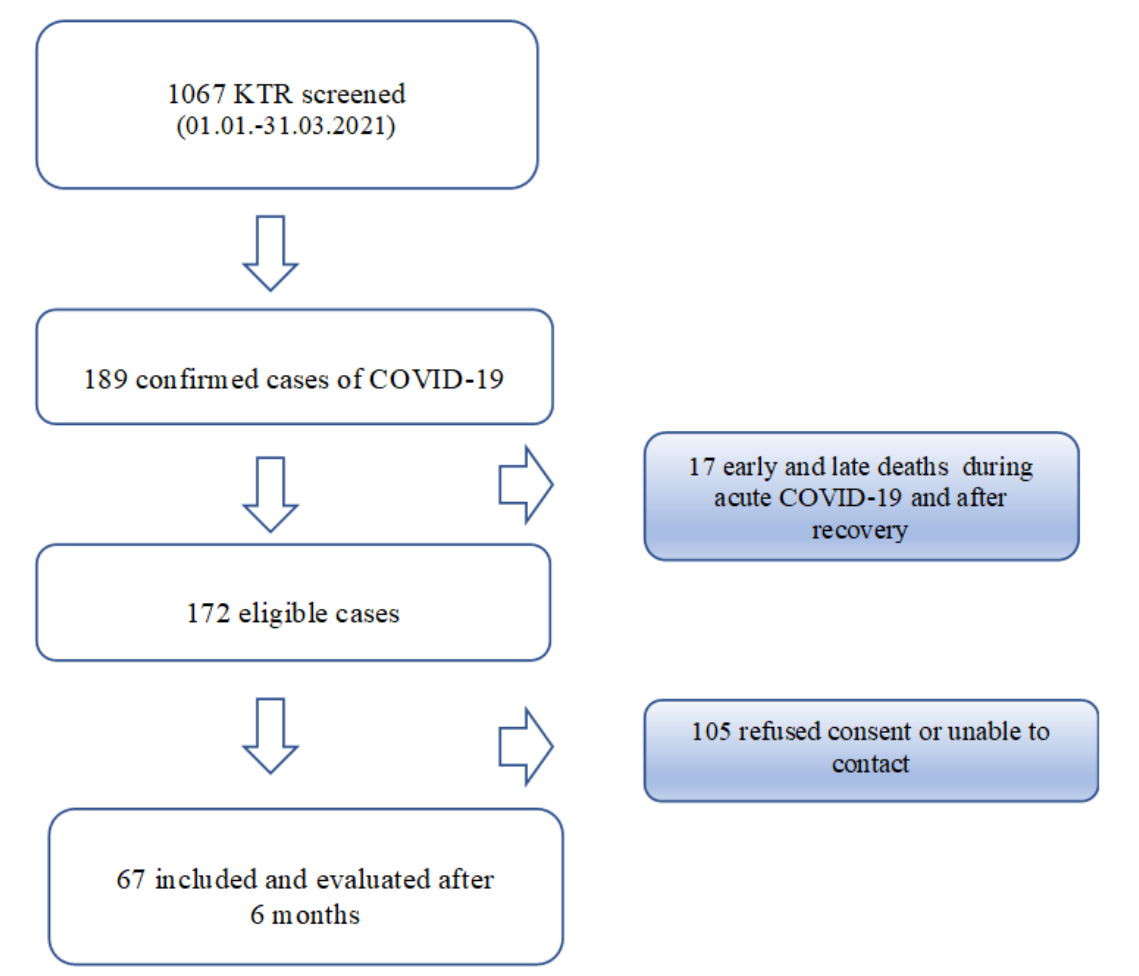
Figure 1. Flow chart of KTR from our institution with SARS-COV-2 infection screened and included in the study. Table 1. Characteristics of study patients.